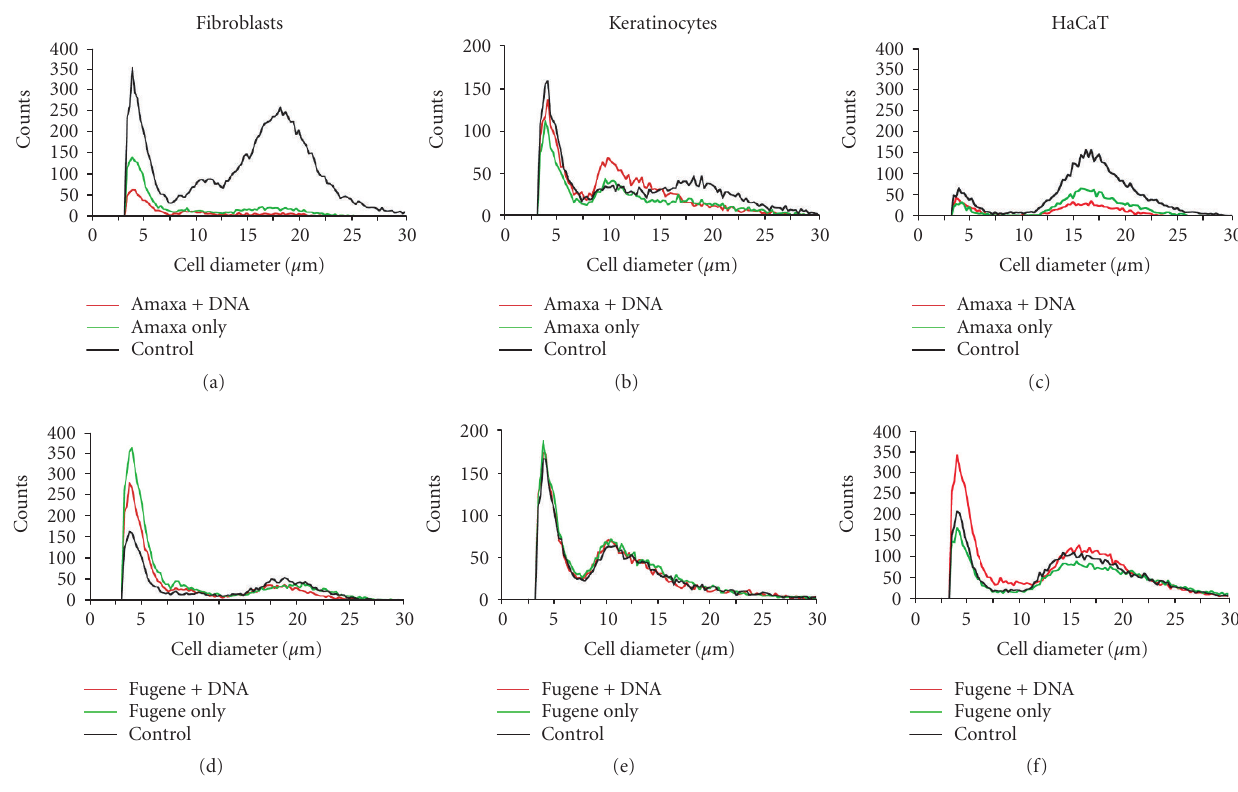
Figure 5: CASY Analysis . Nucleofection (upper panels) and lipofection (lower panels) were correlated by CASY system. Each cell type was treated with (red) or without (green) DNA. Untreated cells served as control (black). Cell counts ( y axis) were plotted against the correlated diameter ( μ m, x axis). The first peak (5–7 μ m) represents the amount of cell debris. Further peaks of higher cell diameter within the same plot refer to di ff erent levels of cell di ff erentiation. A di ff erence of cell diameter was measured only for nucleofected primary keratinocytes. Data are shown as mean